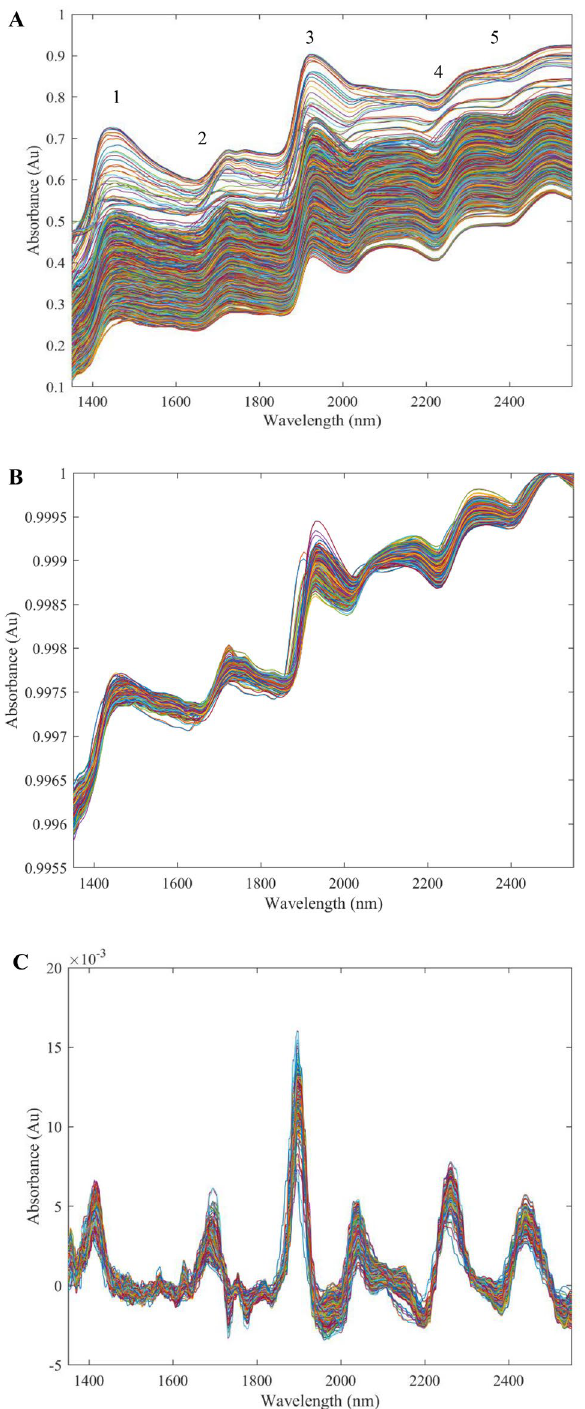
Figure 3. Pre and Post-processed spectra of the complete set of samples (n = 249) obtained using the NIR diffuse reflectance spectrometer in the wavelength region 1350–2500 nm. ( A ) The pre-processed (in absorbance) raw spectra for all 249 samples, including triplicate technical replicates. ( B ) The processed spectra for the models that were not derivatised. Includes models: CBN (19,097), CBC (19,096), CBGA (19,164), CBG (19,164), CBDV (17,199), THCV (19,161) and CBD (19,156). ( C ) Processed spectra that have been derivatised under first order derivatisation for CBDA (19,137), Δ9-THC (19,158), Δ9-THCA (19,179) and THCVA (19,180). For this figure a derivative data transformation was undertaken. The y-axis is the absorbance of reflected molecules in the test samples, the x-axis is the measured wavelength (nm). All spectra values were obtained from the Hone Create Platform. All processed spectra were determined from the software